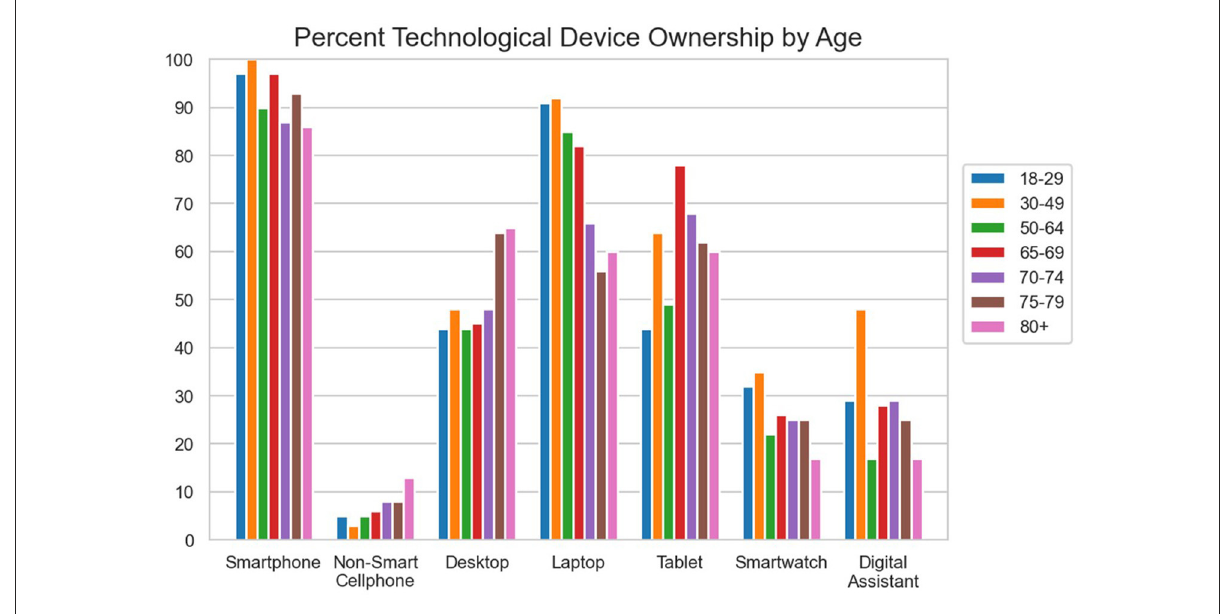
FIGURE1 Rates of ownership of different ICT devices separated by age